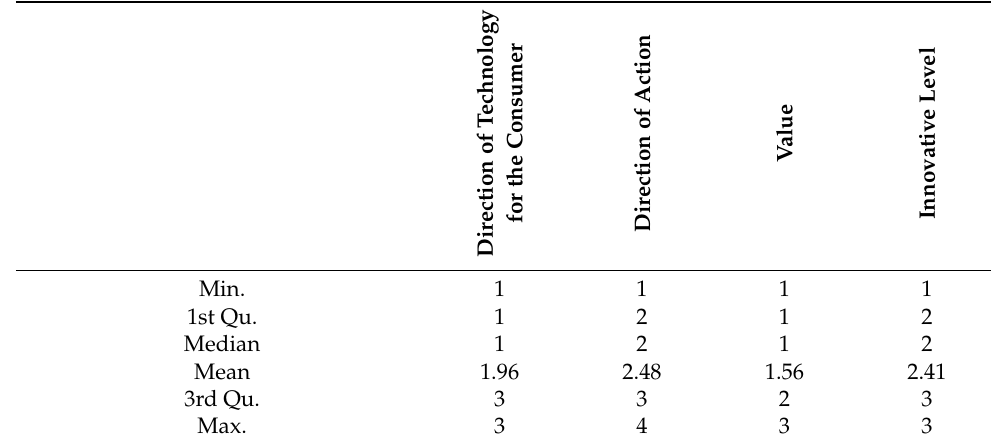
Table A2. Descriptive statistics for the dataset used for